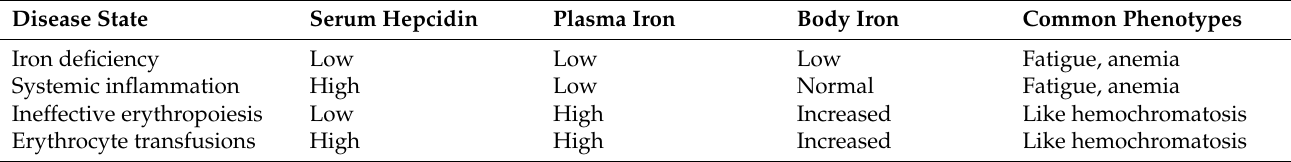
Table 3. Disorders with dysregulated hepcidin